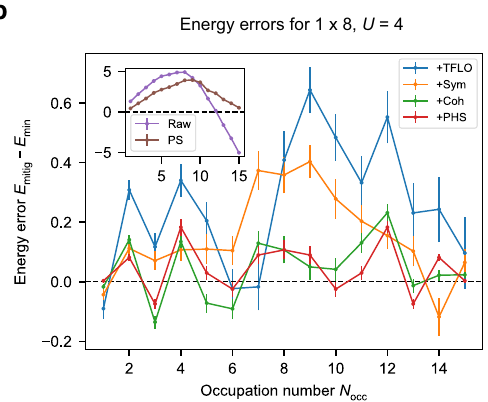
Fig. 3 | Experimental results for the BayesMGD algorithm and fi nal energy errorswithrespecttotheVQEgroundstate.a ProgressofVQEfor1×8and2×4 Fermi-Hubbardinstancesathalf- fi lling,asmeasuredbytheerrorbetweenenergyat parameters θ k and VQEground energy E min (main plot log scale, inset linear scale). “ Estimate ” is the energy estimated by the BayesMGD algorithm during the VQE procedure based on measurement results, “ exact ” is the true energy at the corre- spondingparameters. b Finalerrorsinmeasuredenergyfollowingerrormitigation onthe fi nalstate. “ Raw ” :noerrormitigation. “ PS ” :onlypostselectiononoccupation